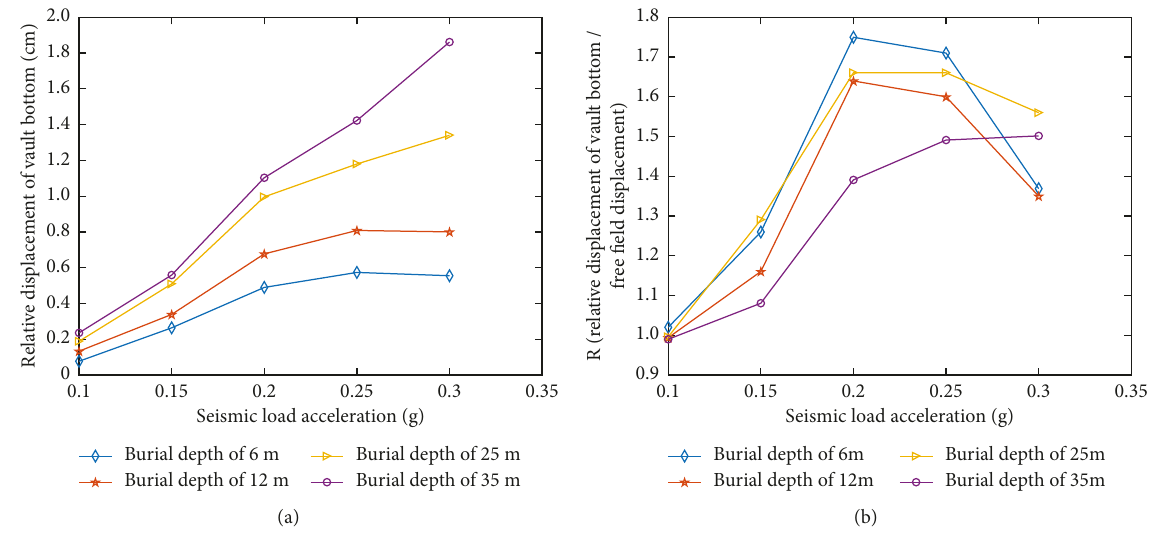
Figure 6: (a) Relative displacement of vault and bottom under different embedded tunnel depths. (b) Distribution of R value under different embedded tunnel depths.